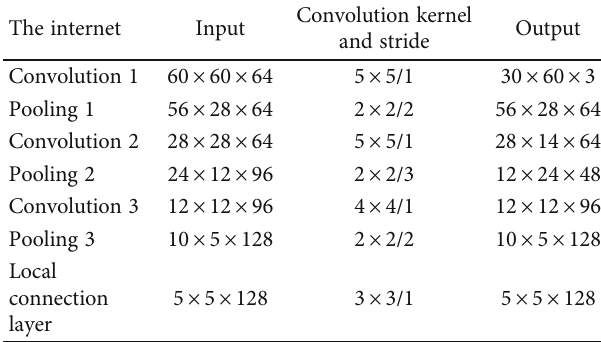
Table 1: Con fi guration of face external contour